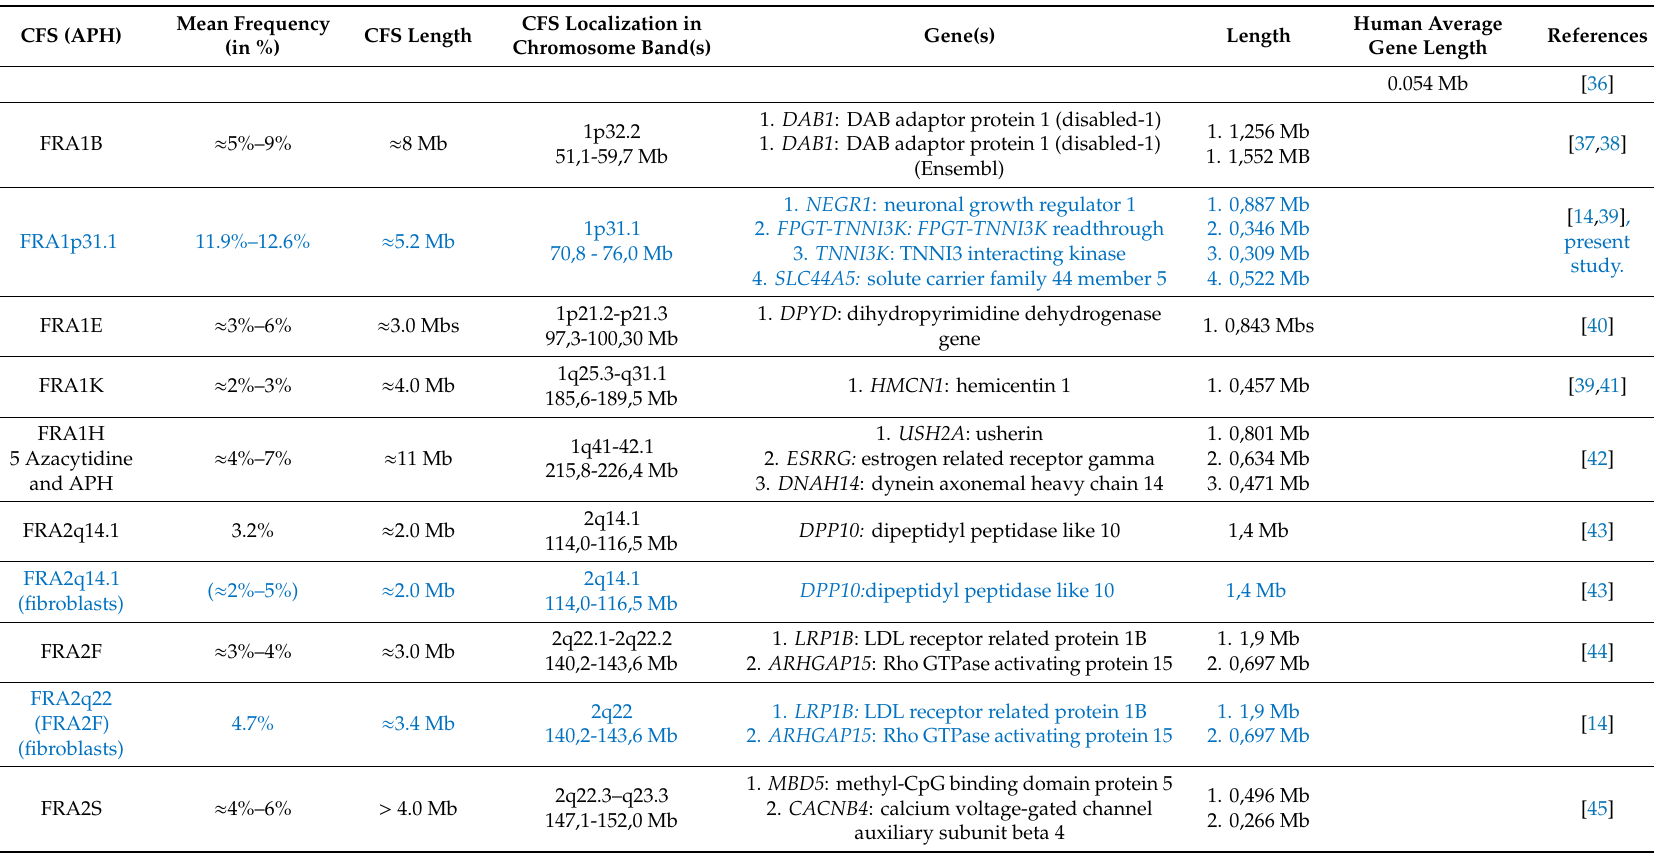
Table 1. Long genes are found in every CFS in lymphocytes and fibroblast cell lines. Genomic locations of all CFSs experimentally characterized in fibroblasts were defined and all genes mapping to the CFS were identified and catalogued, including CFS name / identifier, mean frequency of expression in percentage, total length of the fragile region, total length of the band as seen in cytogenetic analyses, names of genes present within the CFS, and their size (in Mb). The reference for the molecular and cytogenetic characterization of the specific CFS was also